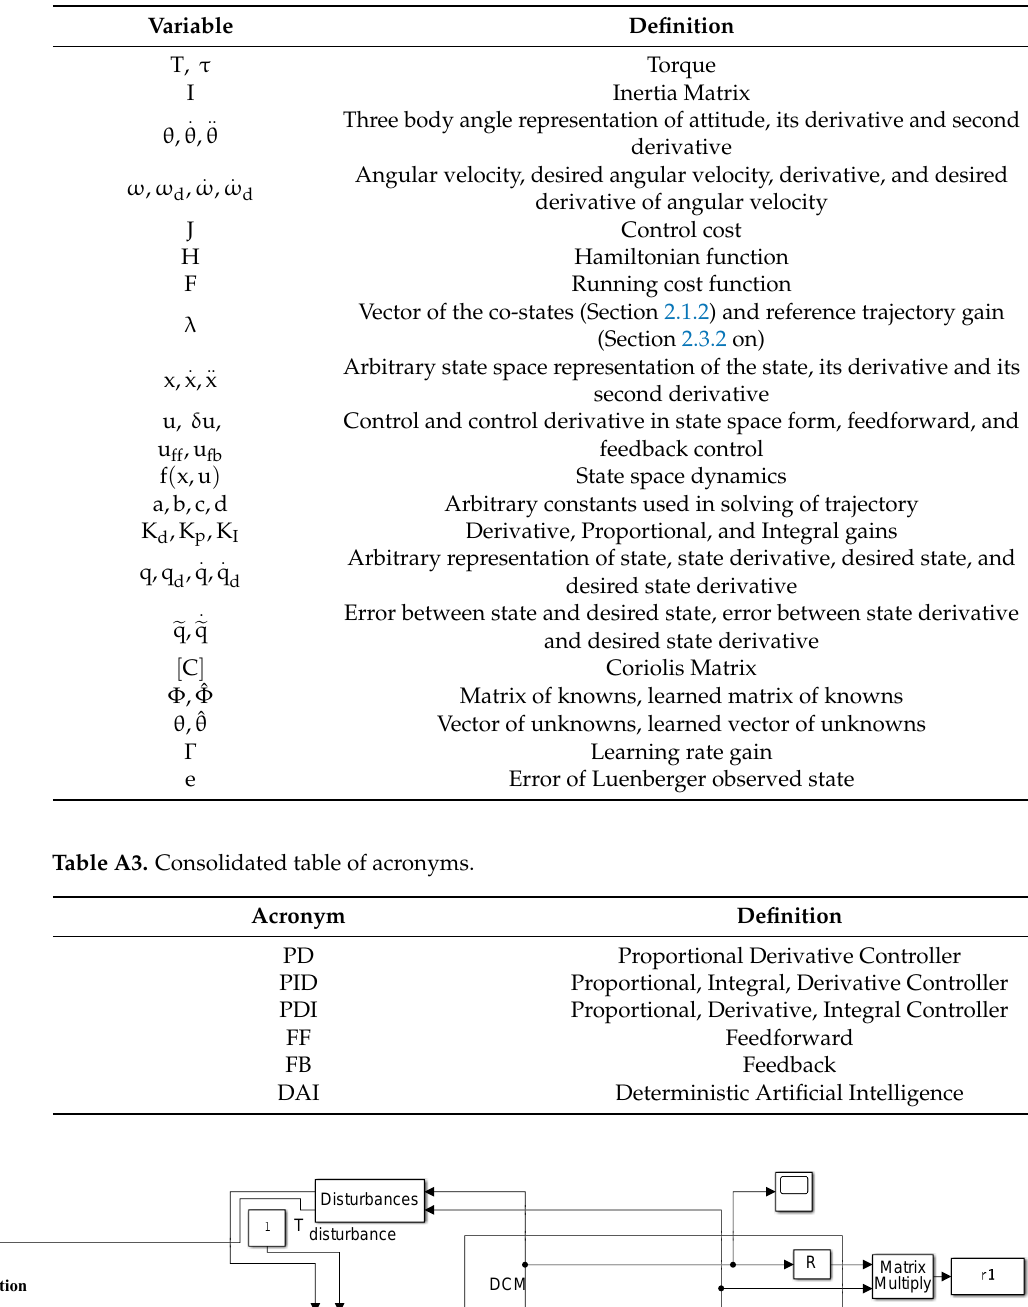
Table A2. Table of variable definitions for Section 2.1.2 through 4.1.